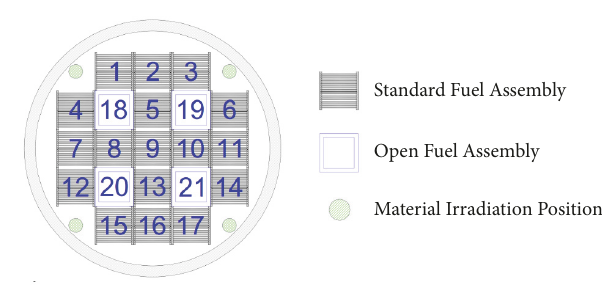
Figure 7: Top view of the CARR multipurpose